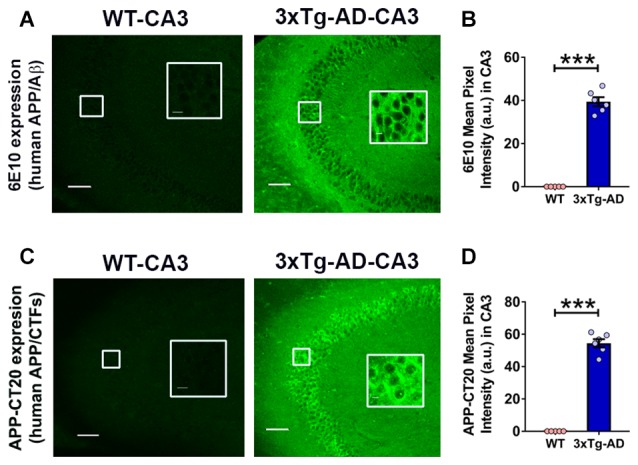
Expression of intraneuronal human amyloid β precursor protein (APP)/amyloid beta (Aβ) in the hippocampal CA3 region of 3-week-old 3xTg-AD mice. (A) Representative photomicrographs showing 6E10 (human APP/Aβ) intraneuronal expression in the hippocampal CA3 region of 3-week-old 3xTg-AD mice; as expected WT mice did not display 6E10 immunoreactivity. No extracellular amyloid plaque deposition was observed. (B) Densitometric quantification of the immunohistochemistry data with 6E10 expression. (C) Representative photomicrographs showing APP-CT20 (human APP/C-terminal fragments, CTFs) intraneuronal expression in the hippocampal CA3 region of 3-week-old 3xTg-AD mice; no expression is observed in WT mice. (D) Densitometric quantification of the immunohistochemistry data with APP-CT20 expression. The data are shown as mean ± SEM from WT (n = 5) and 3xTg-AD (n = 6), and compared using Student’s t-test. Insets show the designated areas at higher magnification. Scale bar = 100 μm. ***p < 0.001.